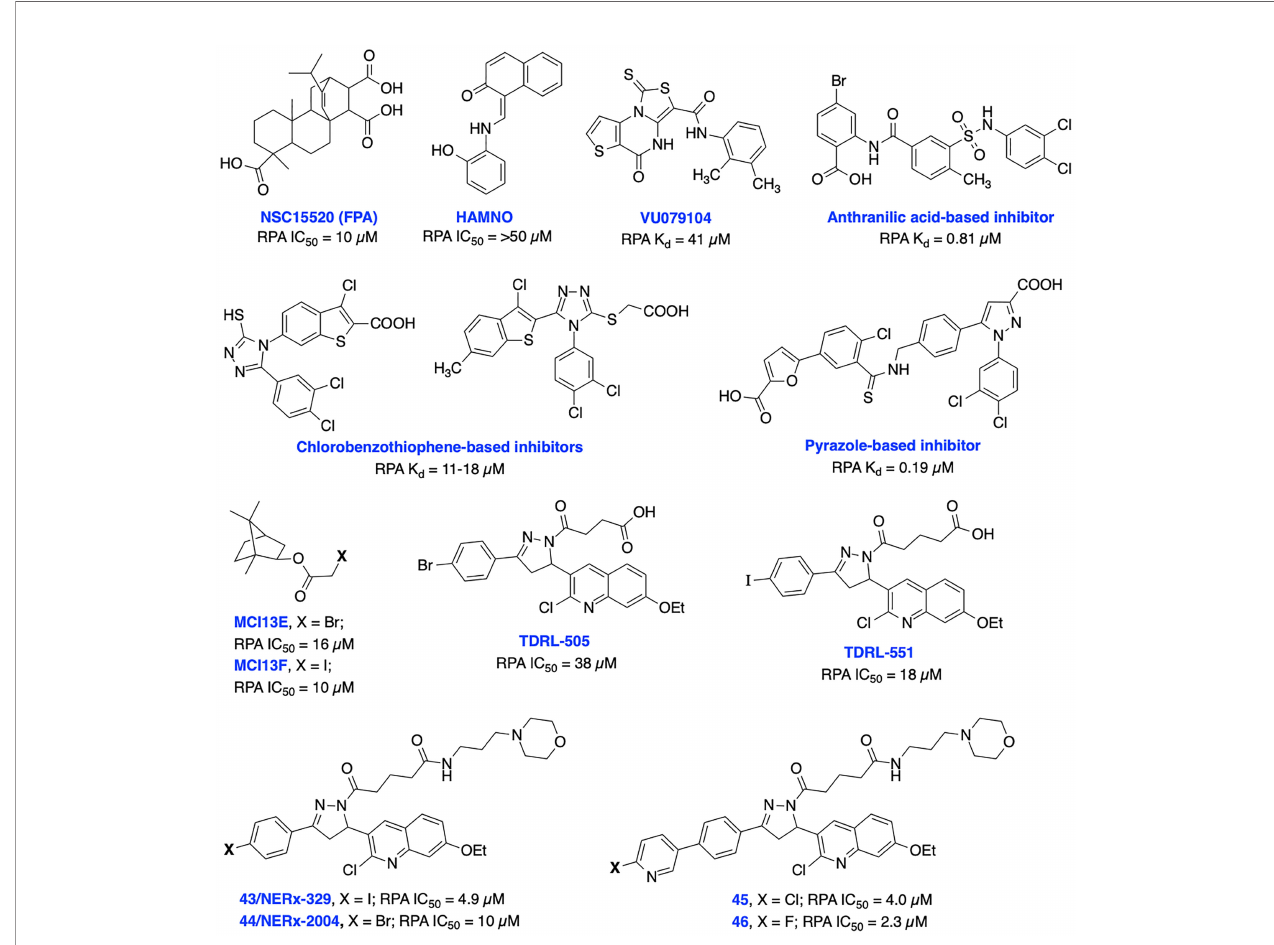
FIGURE 9 | Small molecule inhibitors targeting RPA N-terminal protein-protein interactions and RPA-DNA interactions with their respective Kd/IC50